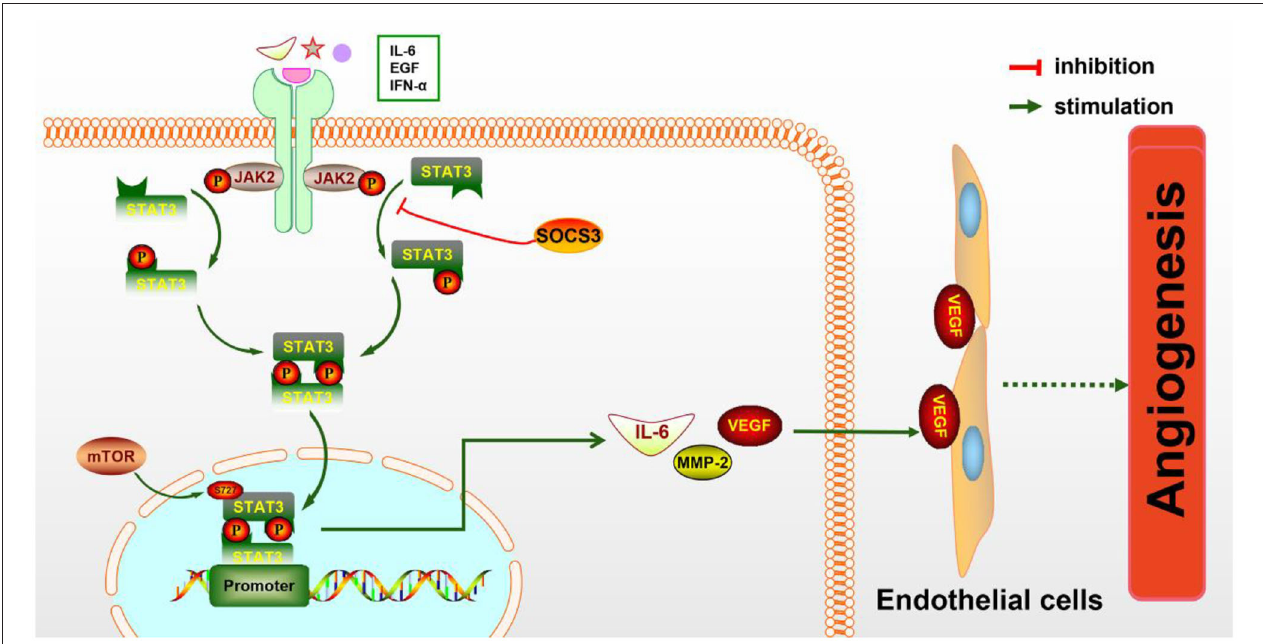
FIGURE 1 | The molecular mechanism of angiogenesis mediated by the JAK2/STAT3 pathway. JAK2 is activated and phosphorylated by inflammatory cytokines such as IL-6 and IFN- α , resulting in the phosphorylation of downstream STAT3 and the formation of the p-STAT3 dimer, which is subsequently transferred to the nucleus to promote the expression of particular genes. IL-6, MMP-2, VEGF, and other cytokines are increased, then secreted to the extracellular matrix and act on endothelial cells (ECs), eventually leading to increased angiogenesis.